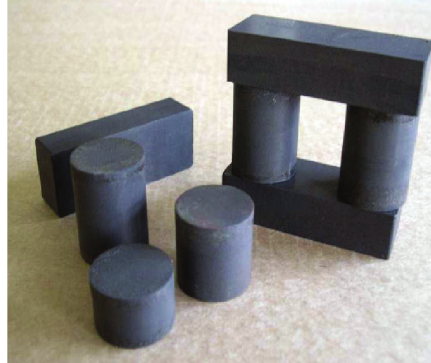
Figure 2: Low permeable block and cylindrical Sendust (CoolM 𝜇 ) metal powder cores.